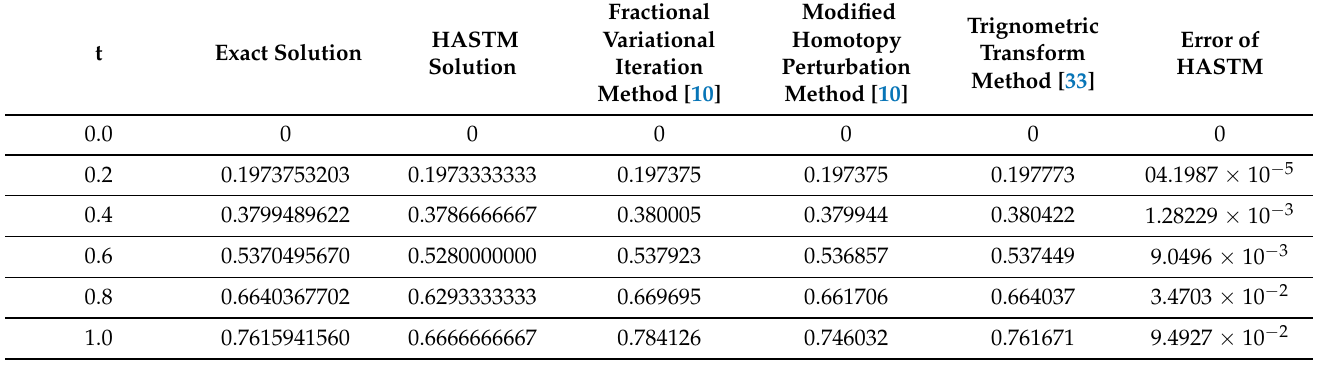
Table 3. Comparative analysis of the numerical results for u ( t ) at (cid:125) = − 1 and µ = 1 for Example 3.